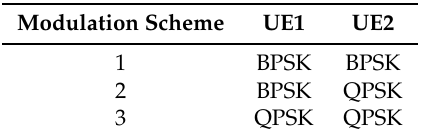
Table 2. Parameter settings used in the